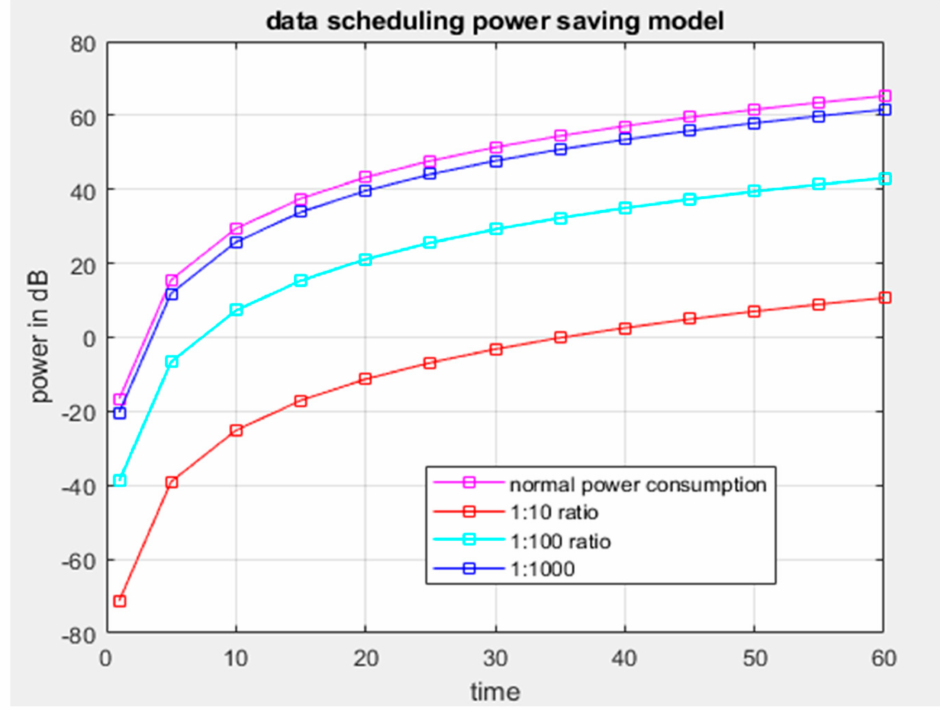
Figure 11. Data scheduling power-saving model.